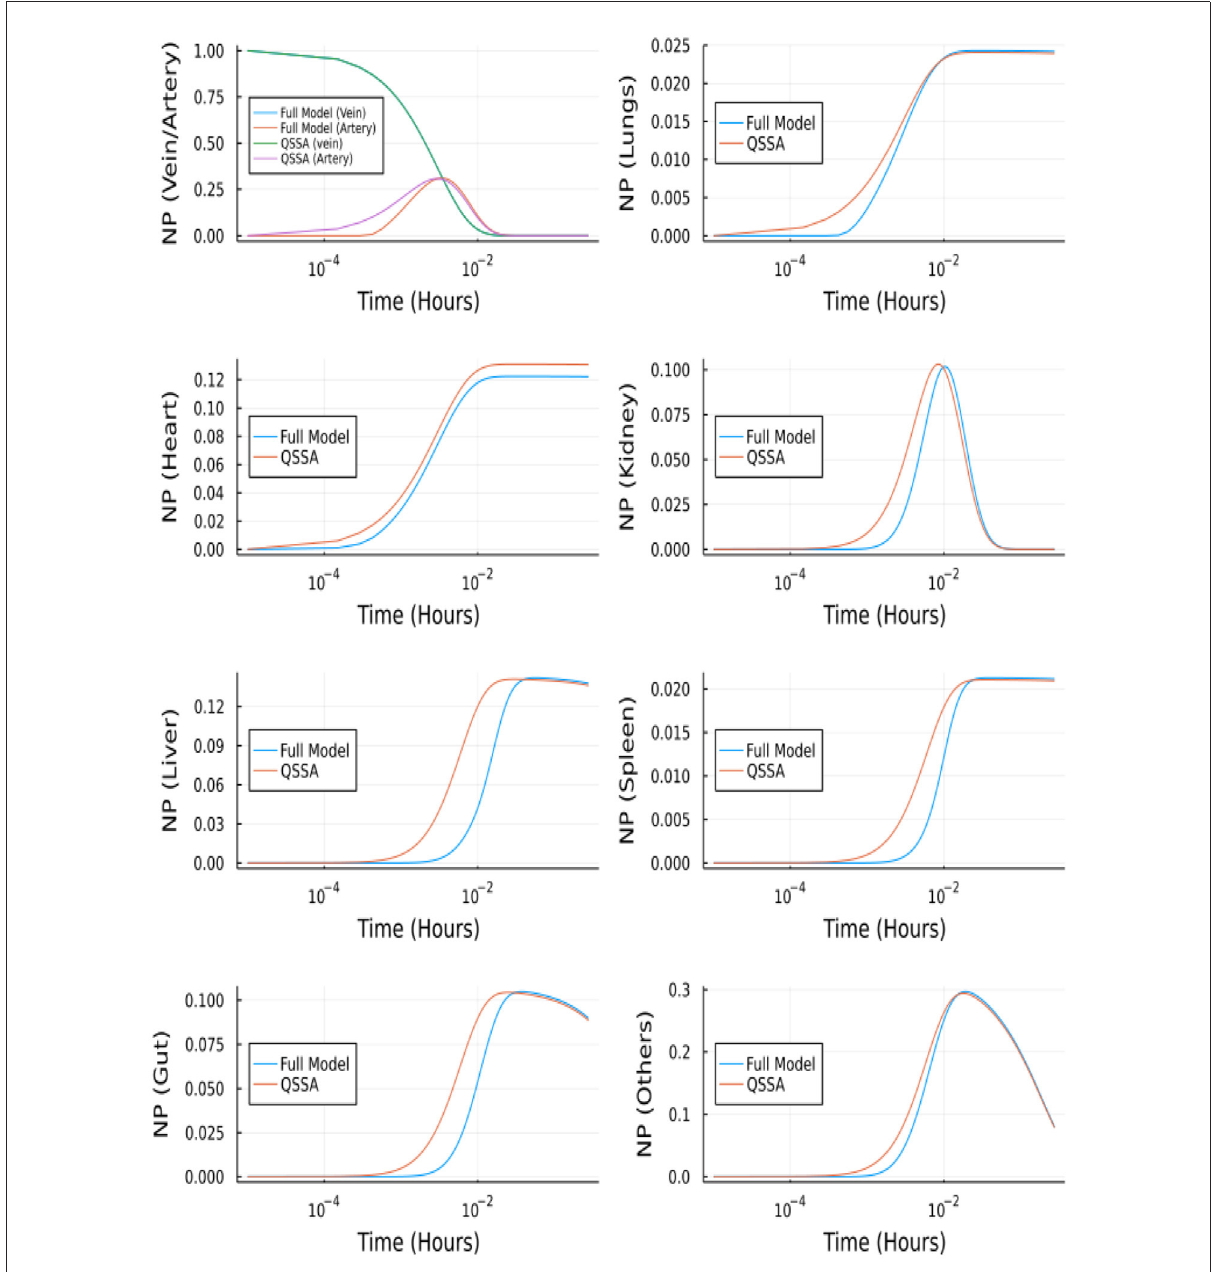
FIGURE13 Comparison between complete model and QSSA for branched